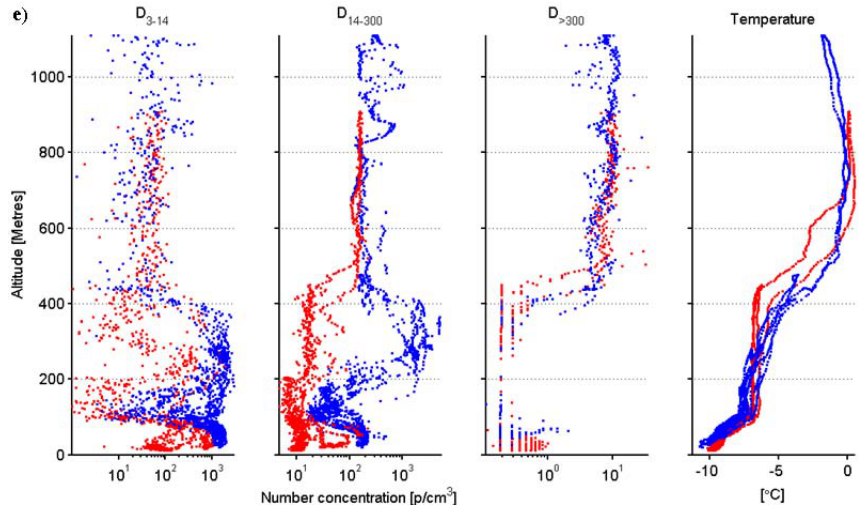
Fig. 9e. Vertical profiles of aerosol particle number concentration and temperature during ASCOS 2008 expedition helicopter flights, Period